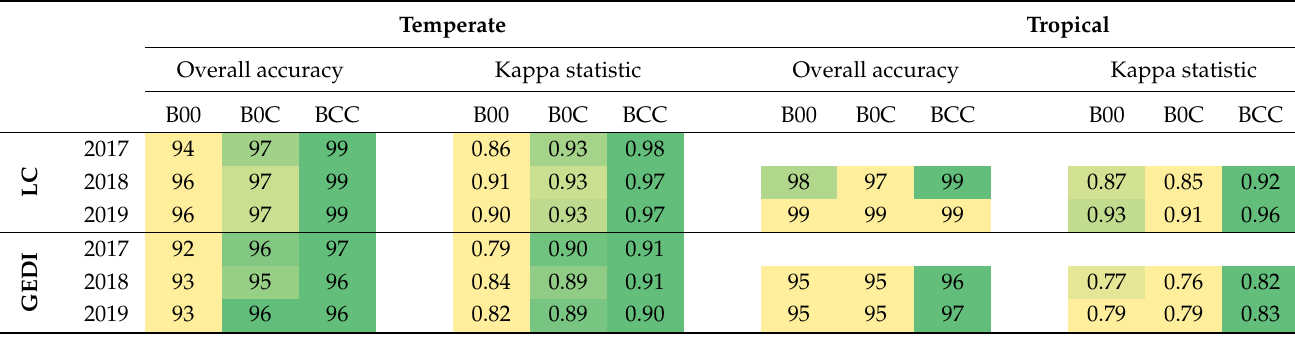
Table 3. Overall accuracy (%) and kappa by classification. “LC” stands for land cover-based reference dataset. B00—classification using backscatter annual statistics, B0C—adding long-term coherence, and BCC—further adding short-term coherence statistics. Cells are shaded with a gradient between yellow and green, associated with lower, and higher metrics, respectively.